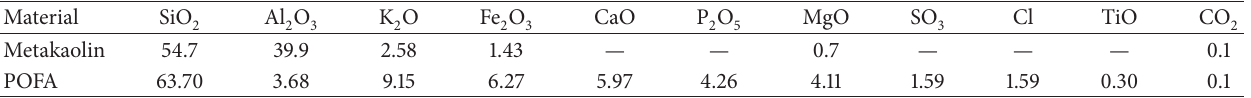
Table 1: Chemical composition of Metakaolin and POFA.